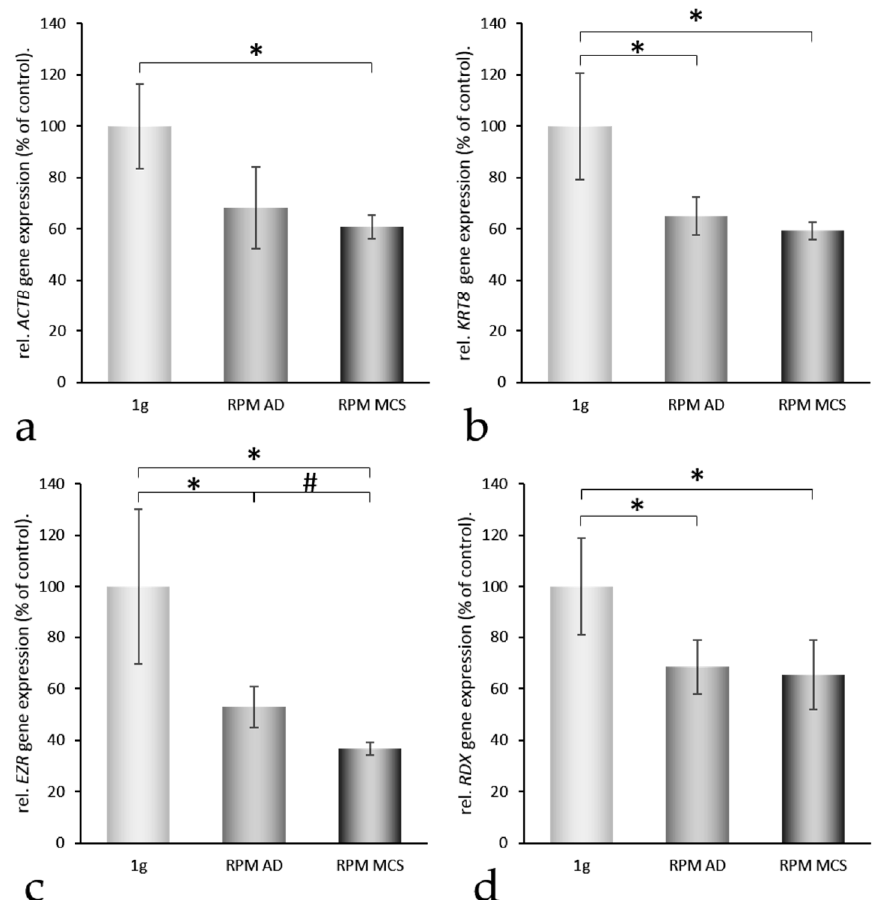
Figure 3. Cont. Figure 3.